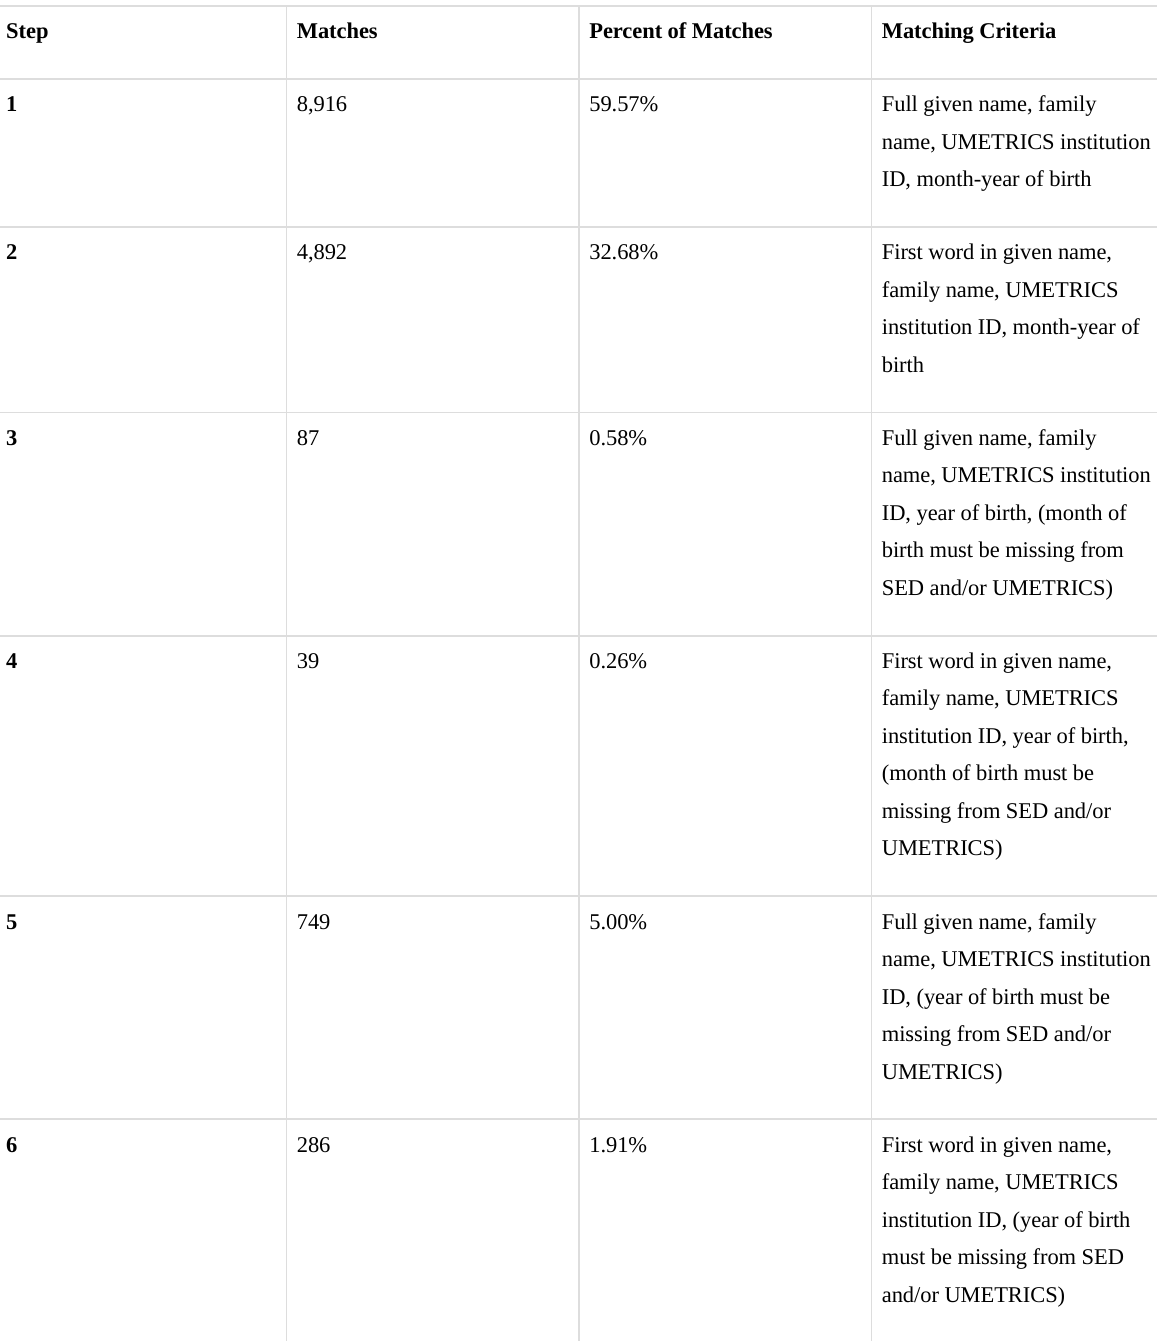
Table A2. Match counts by matching